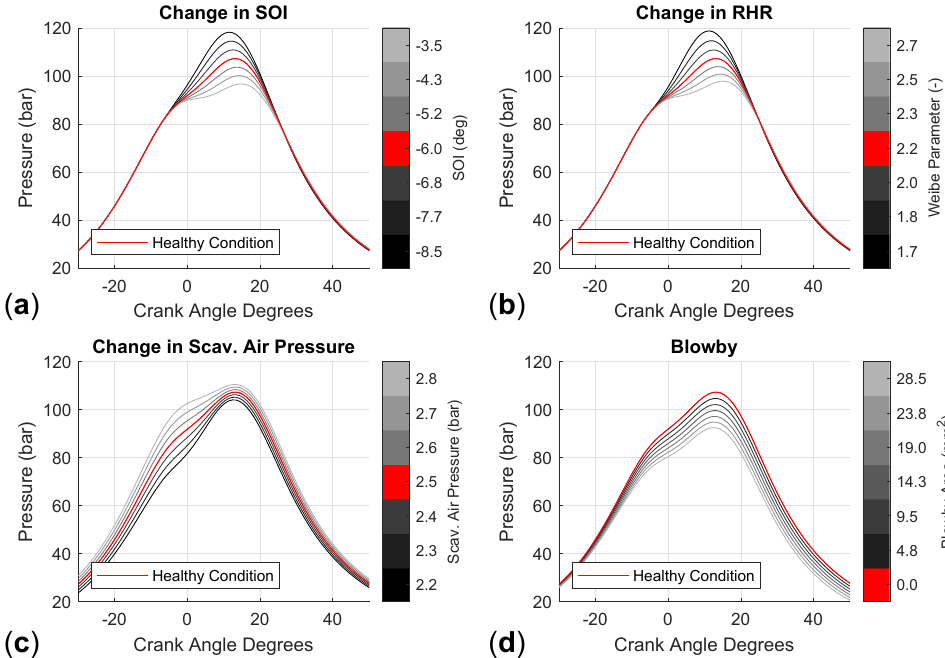
Figure 4. In-cylinder pressure for the healthy and malfunctioning conditions of ( a ) change in SOI, ( b ) change in RHR, ( c ) change in scavenge air pressure, and ( d ) blowby.